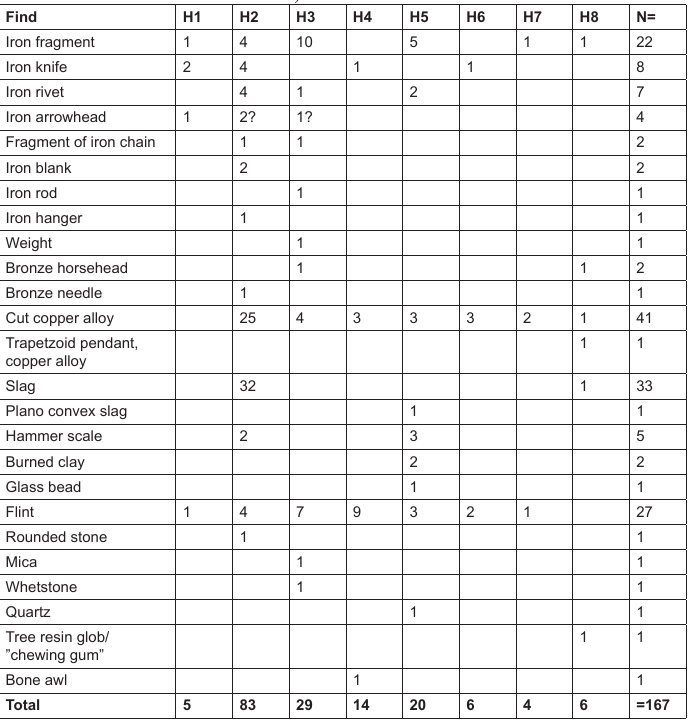
Table 2. The artefacts from